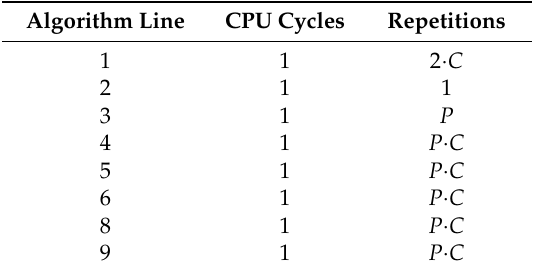
Table 2. Computational cost of Algorithm